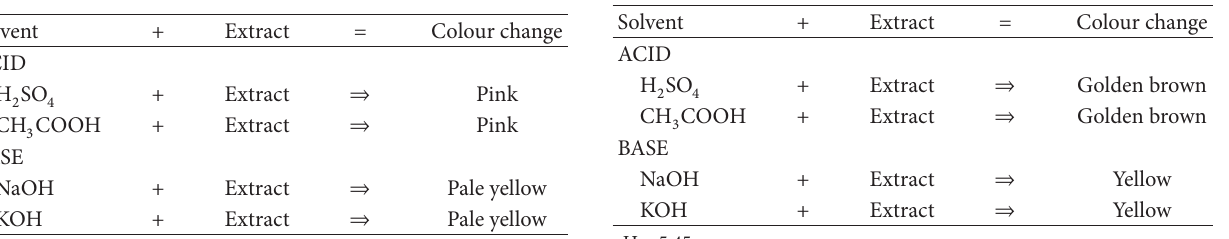
Table 5: Allamanda extracts (methanol extract) (initial colour of extract, brown).